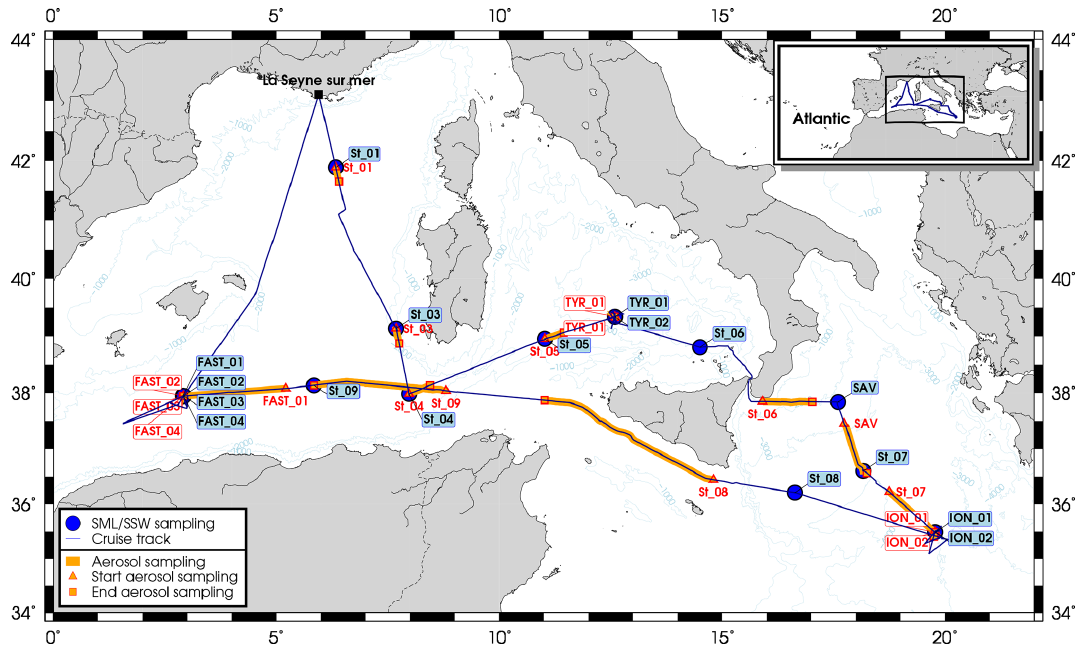
Figure 1. Location of the sampling stations during the PEACETIME cruise (10 May to 11 June